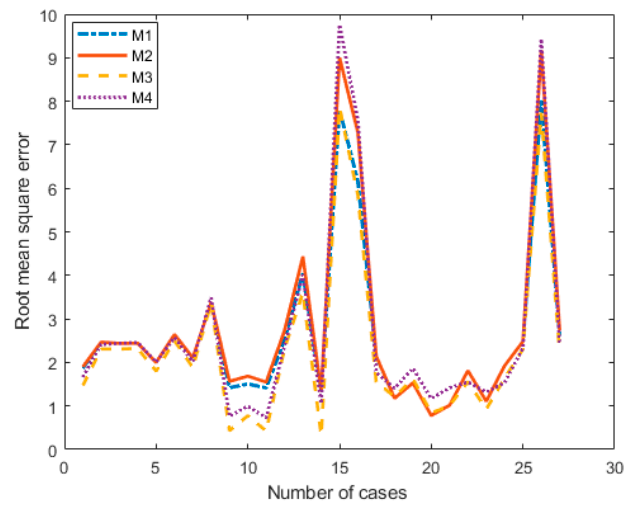
Figure 2. Comparison of the RMSE value.